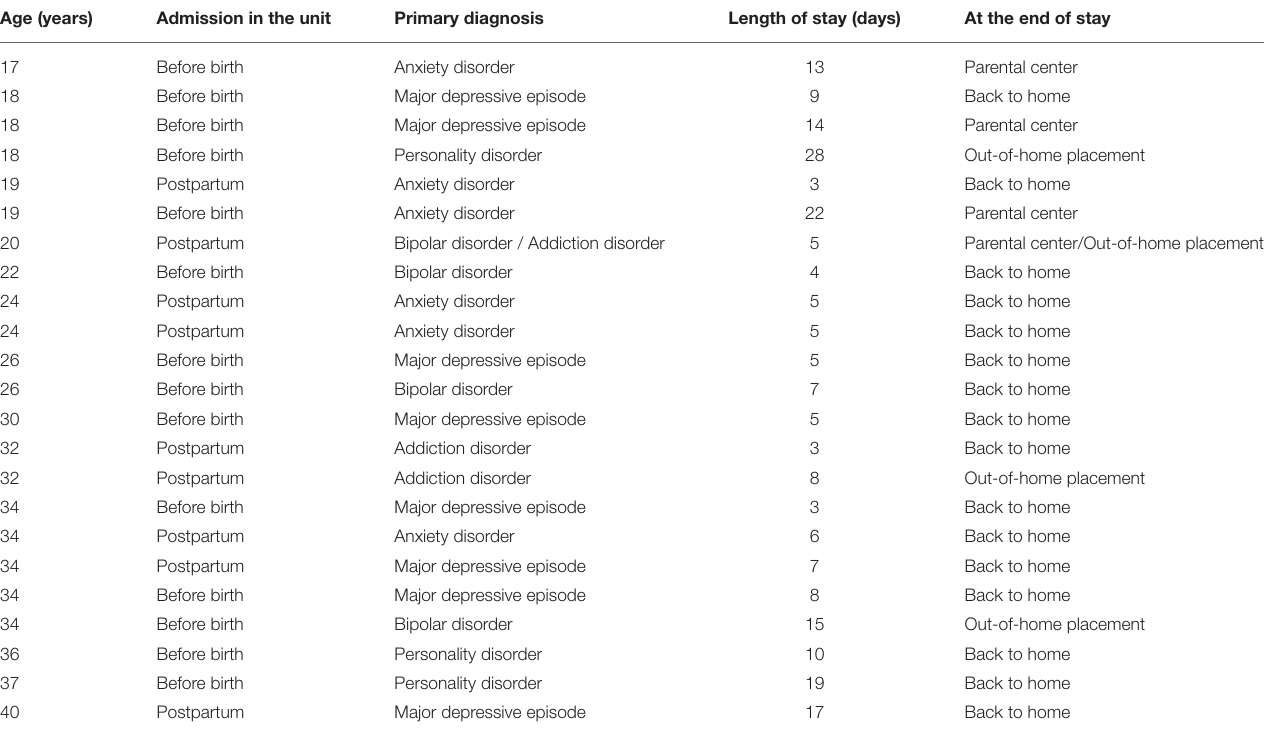
TABLE 1 | Age, referral to the unit, primary diagnosis, length of stay and end of stay orientation for the 23 women of the sample. Age